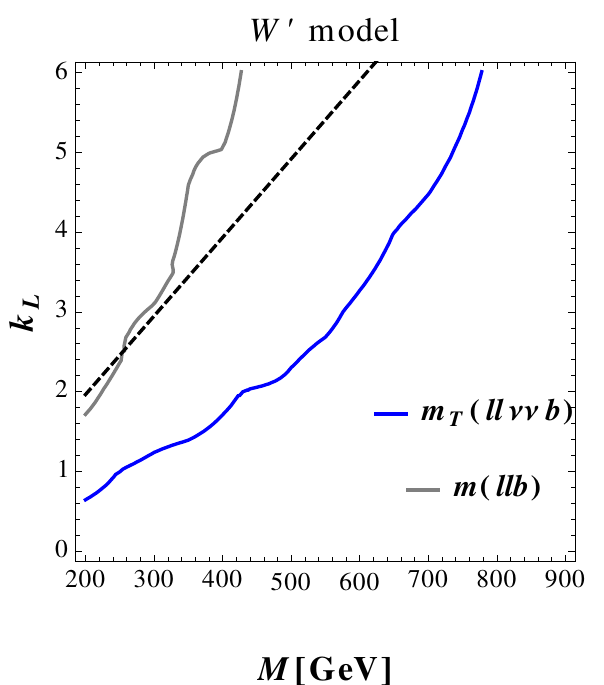
Figure 9 . 95% CL bounds in the M vs k L plane obtained by using the m ( llb ) (grey curve) and m T ( ll(cid:23)(cid:23)b ) (blue curve) di(cid:11)erential distribution measurements at 36.1 fb (cid:0) 1 . The dashed black line represnts the EFT bound of eq.